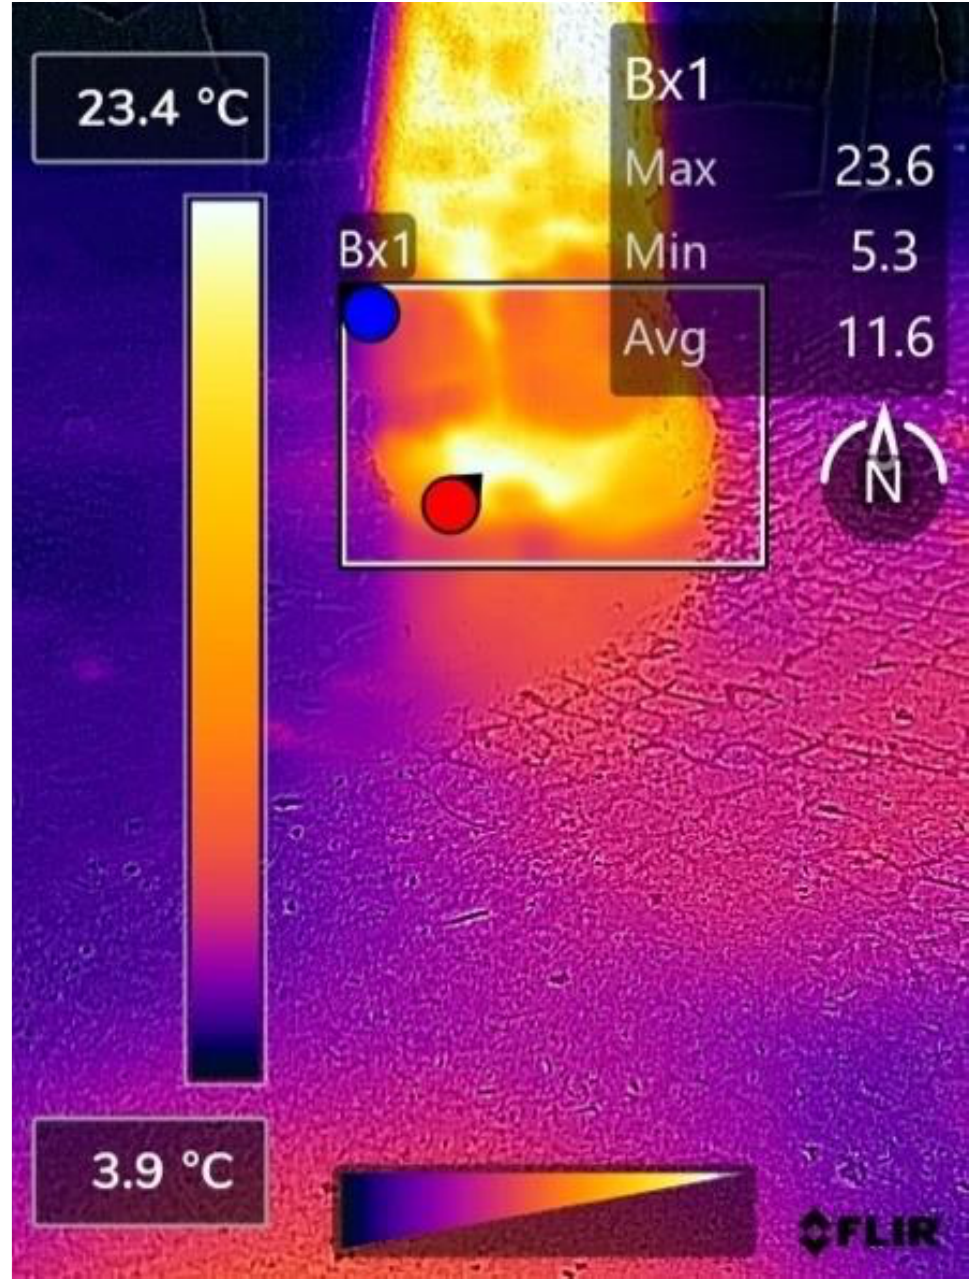
Figure A4. A thermogram, obtained by the CAT s62-Pro Smartphone (LCD), of cattle diagnosed with digital dermatitis on routine foot trimming, displaying a pattern of heat with maximum intensity over the interdigital space, rather than between the heel bulbs.